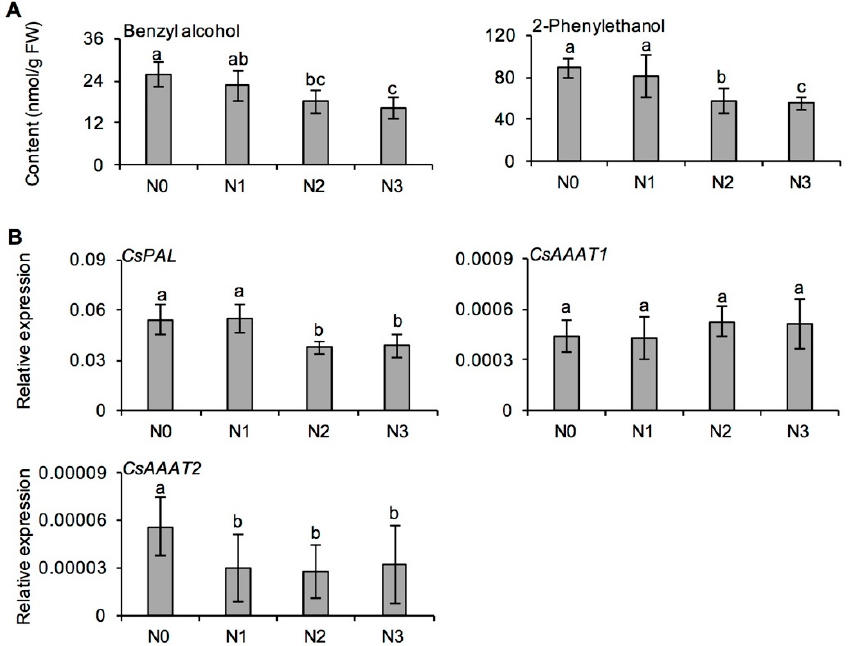
Figure 5. Effects of long-term nitrogen application on the content of aroma compounds derived from L -phenylalanine metabolic pathway ( A ), and expression of phenylalanine lyase ( CsPAL ) and aromatic amino acid aminotransferase 2 ( CsAAAT2 ) ( B ) in fresh tea leaves collected in spring. The nitrogen application treatments indicate N0: 0 N kg/hm 2 ; N1: 112.5 N kg/hm 2 ; N2: 225 N kg/hm 2 ; N3: 450 N kg/hm 2 , respectively. Values followed by different letters (a–c) mean significant at the 5% level among different treatments.